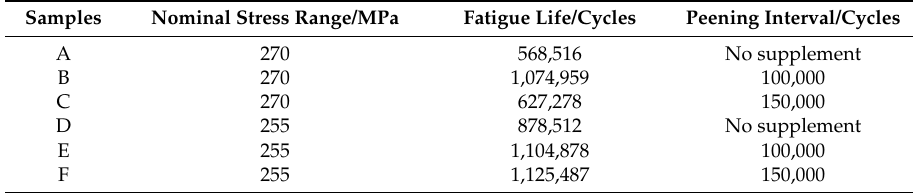
Figure 6. Fatigue life of UPT-welded joints and UPT supplement joints. Table 3. Fatigue data of six